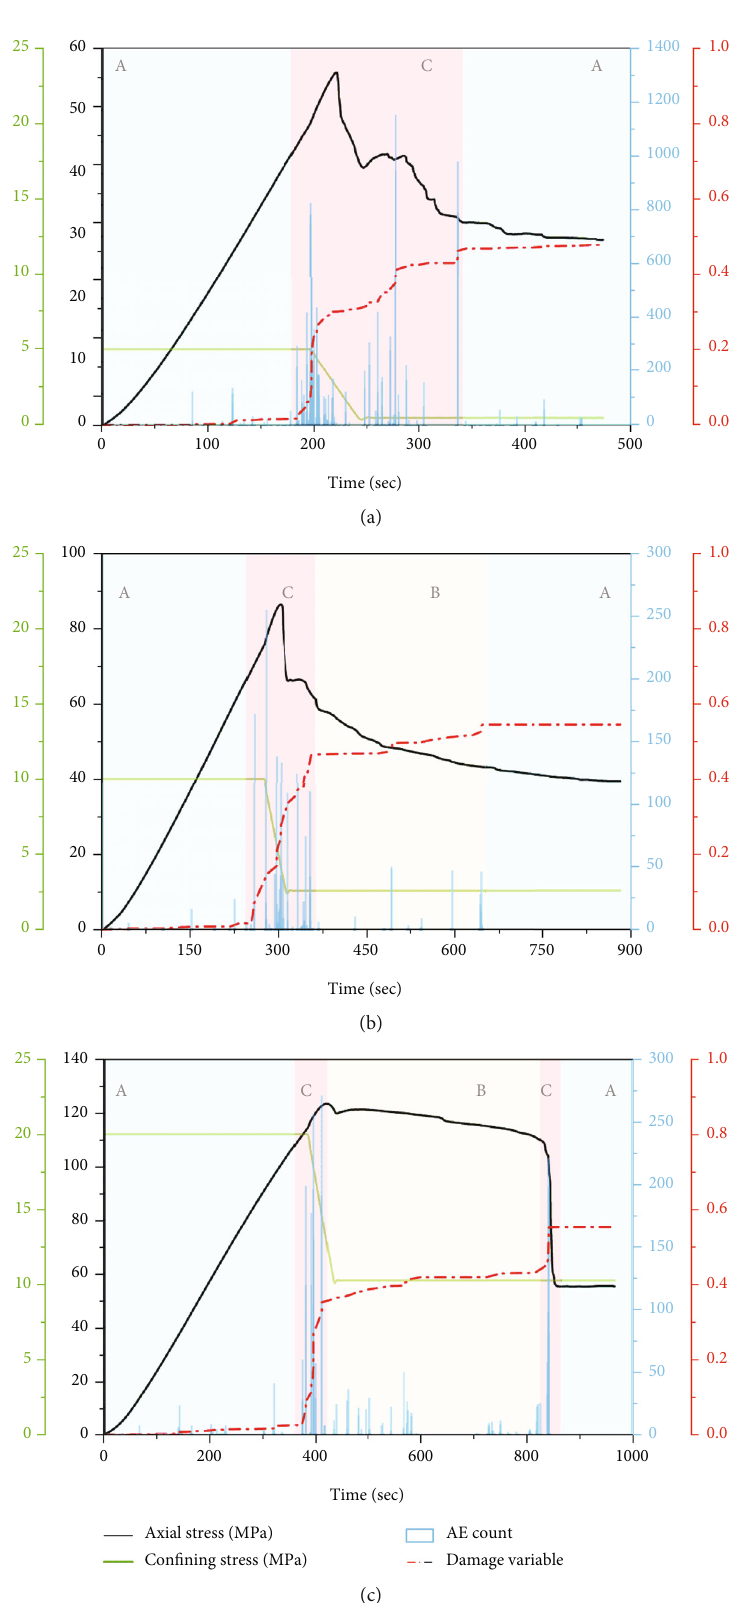
Figure 12: AE ringing count/damage variable-time relations of Scheme 3 under di ff erent con fi ning pressures (con fi ning pressure setting: (a) 5MPa, (b) 10MPa, and (c)